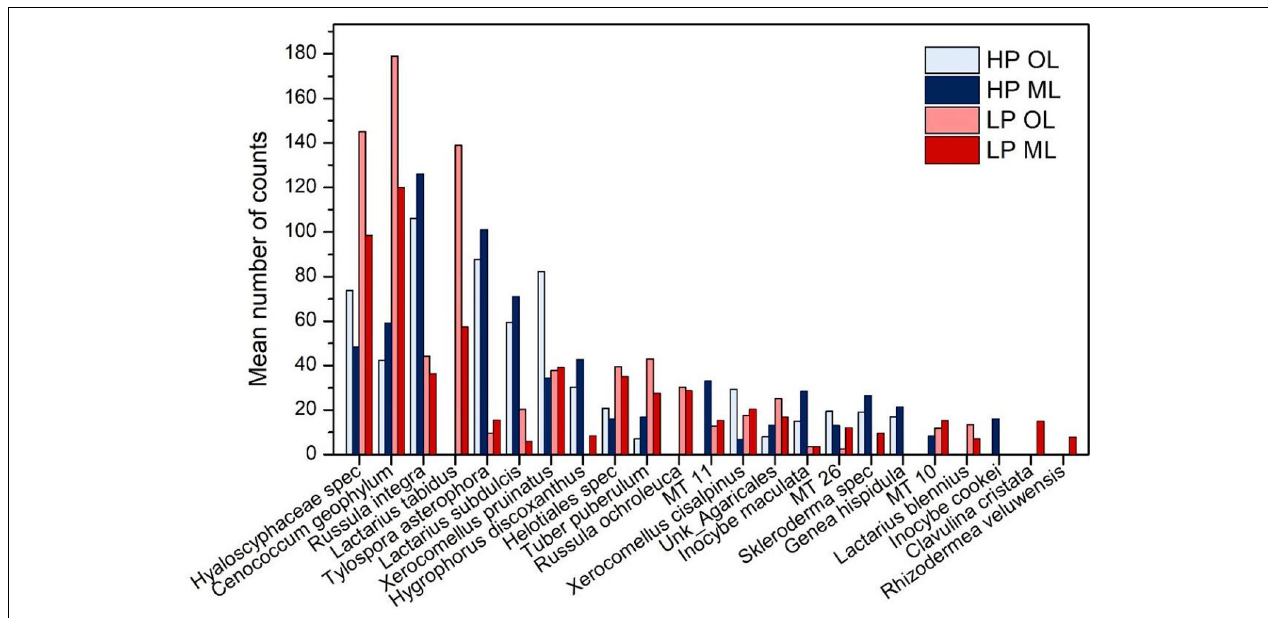
FIGURE 5 | Ectomycorhizal species colonizing beech ( Fagus sylvatica ) roots in P-rich (HP: blue) and P-poor (LP: red) forest soil. Species were analyzed by morphotyping and ITS sequencing of the fungal morphotypes. Supplementary Table S4 shows additional information on species identification. Roots from the organic layer (OL, light blue, light red) and the mineral topsoil (ML: dark blue, dark red) were analyzed separately.